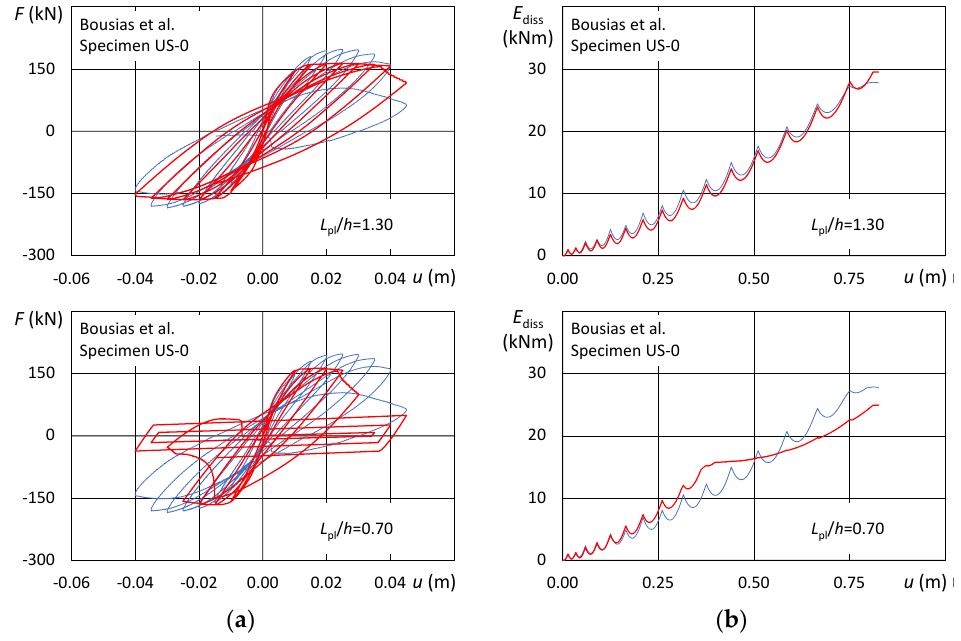
Figure 6. Comparison between results of the laboratory test US − 0 and numerical responses for two values of length of plastic hinge ( L pl / h = 1.30 or 0.70): ( a ) lateral load versus lateral displacement, ( b ) energy subtended by cycles versus cumulated lateral displacement. Notes: (blue line) laboratory test; (red line) numerical analysis.